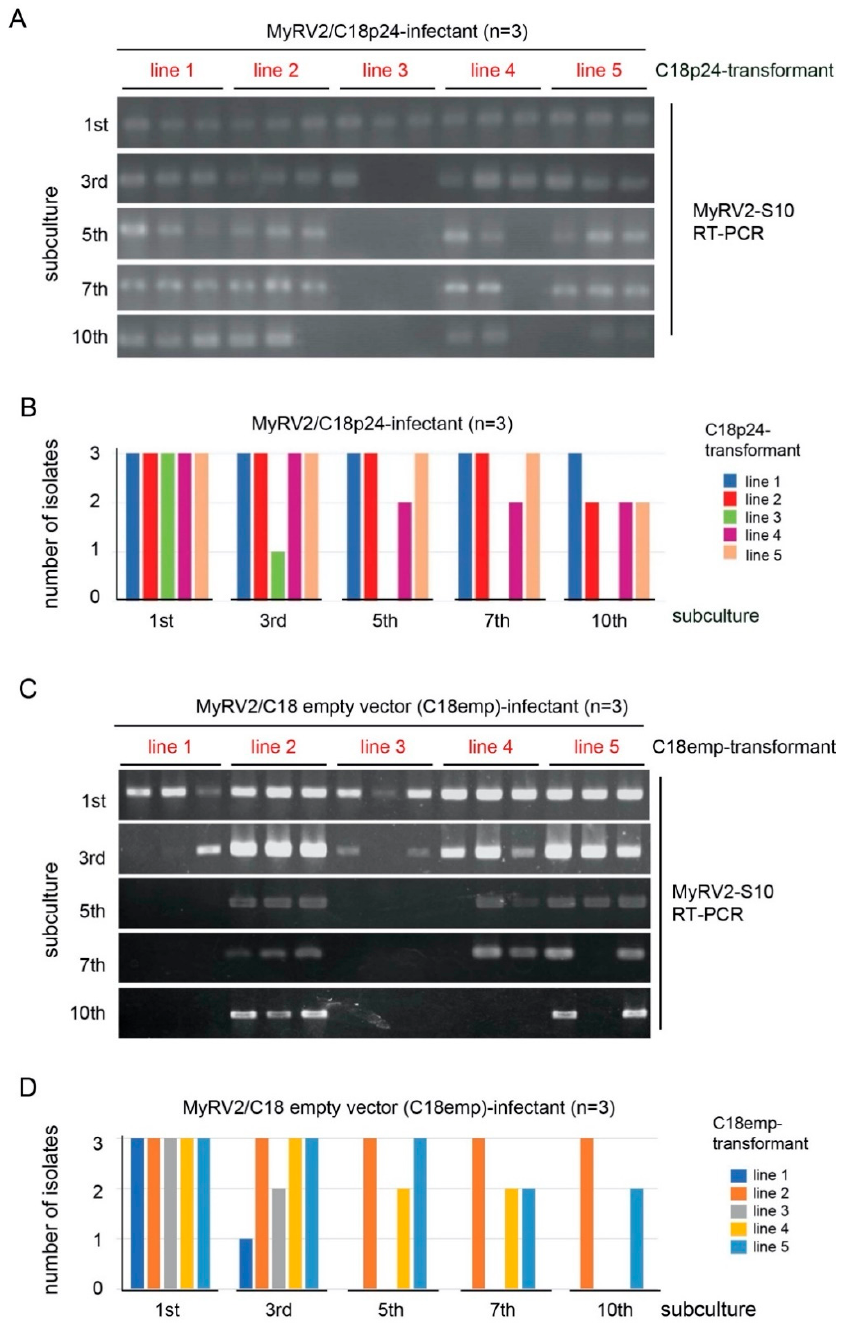
Figure 5. Enhanced infection stability of MyRV2 by transgenic expression of CHV4-C18 p24. ( A , C ) Detection of MyRV2 infection by RT-PCR in C18 transformants with the CHV4 p24 coding domain (C18p24) or the empty vector (C18emp). Virus infection in three transfectant subisolates from 5 independent transformants (lines 1 to 5) was monitored until 10th subcultures by colony RT-PCR. RT-PCR was carried out as described by Aulia et al. [28] using the primers CHV4-287_F and CHV4-853_R. Amplified fragments were analyzed in 1.2% agarose gel electrophoresis. ( B , D ) MyRV2 Infectivity after successive fungal subculture in C18p24 transformants ( B ) and transformants with the empty vector (C18emp) ( D